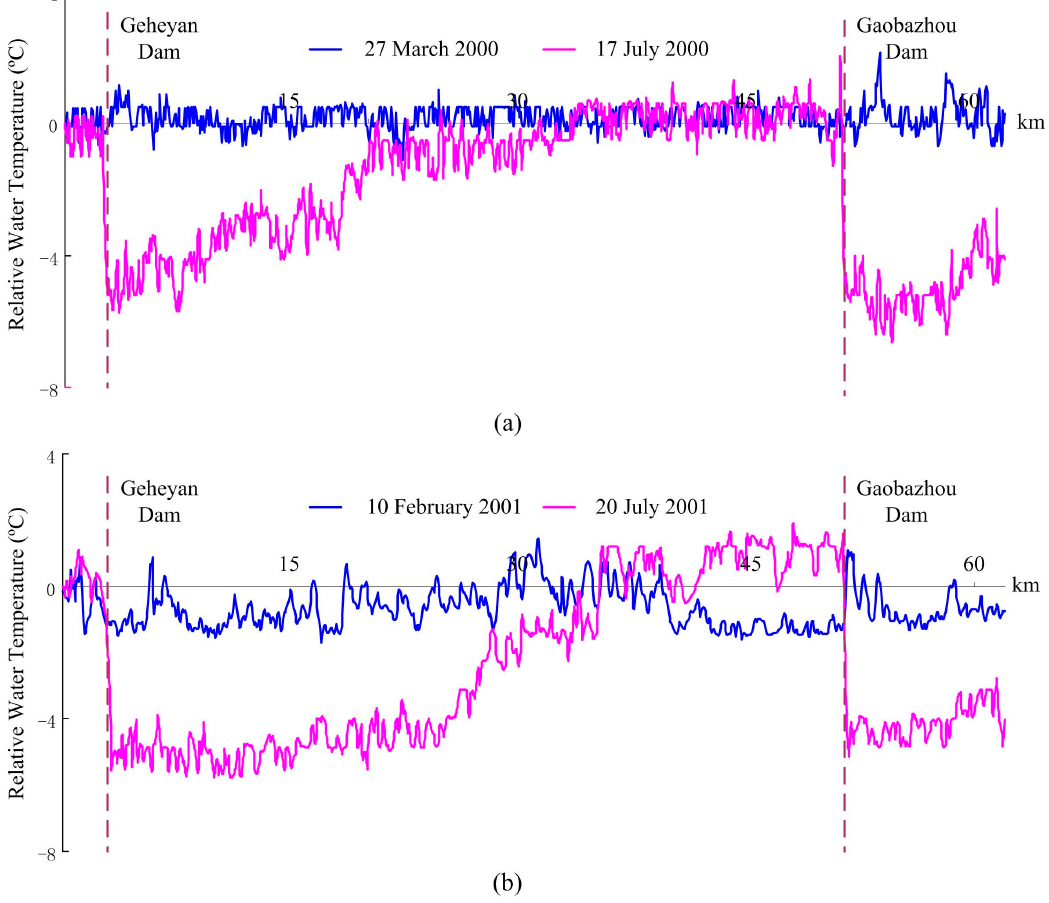
Figure 8. Longitudinal profiles of relative water temperatures from the reservoir upstream of the Geheyan Dam to the river mouth over different times.